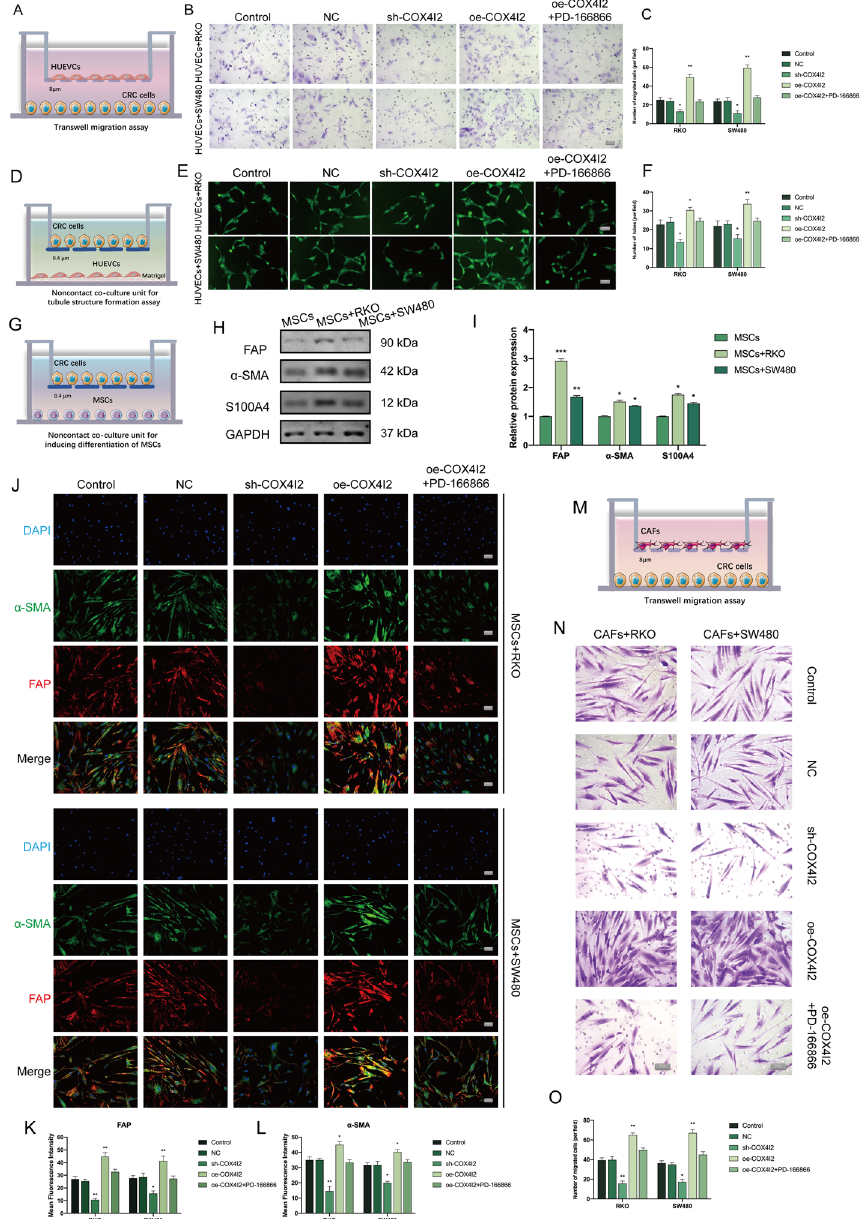
Fig. 7 Overexpression of COX4I2 promotes angiogenesis and CAF activation in CRC. a The HUVEC migration assay. b , c HUVEC migration analysis (Transwell assay) (magnification: formation assay. e , f HUVEC tube formation and graph showing tube formation indices in different groups (magnification: 200, scale bars: 50 μm). g Non‑contact co‑culture of MSCs and CRC cells. Cells were used × in a 1:1 ratio. h , i Western blot showing CAF‑related markers after 5 days of co‑culture ( n Immunofluorescence of MSCs co‑cultured with CRC cells (control cells and CRC cells transfected with the NC, sh‑COX4I2, and oe‑ COX4I2 constructs) treated with or without 5 µM PD‑166866 (magnification: scale bars: 20 μm). m The CAF migration assay. n , o Recruitment of CAFs by CRC cells (Transwell) (magnification: 200, scale bars: 50 μm). Cell numbers were assessed using Image J. Data are expressed as × the mean SEM. Asterisks indicate a significant difference at * P < 0.05, ** P < 0.01, *** P < 0.001. All experiments ± were repeated at least three times, independently. For Abbreviations, see Abbreviation